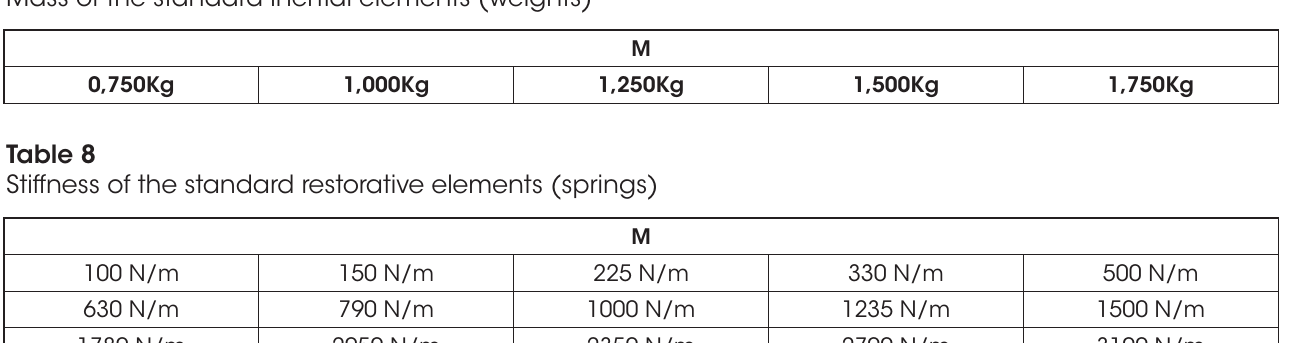
em que: f = a frequência natural do Tuned-Mass Damper. TMD k = rigidez do sistema, ou seja, da mola. m = massa do elemento inercial.